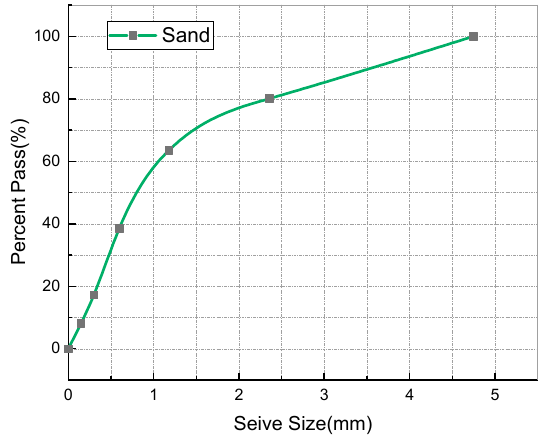
Figure 3. Particle size distribution of RCA and NCA.